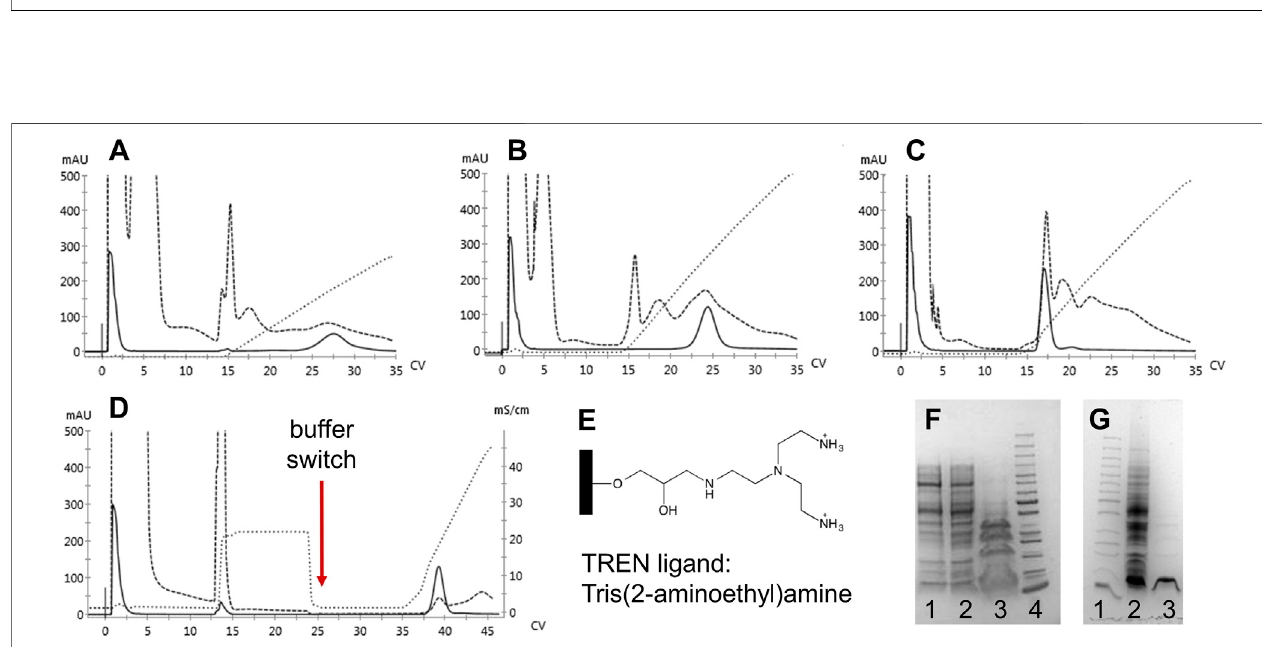
FIGURE 4 | Chromatograms of 1 ml BabyBio TREN chromatographic runs are shown in A-D. Dashed lines indicate the 280 nm UV trace, solid lines indicate 419 nm,anddottedlinesshowtheincreaseinconductivityduringelution.rHbF α 4/ γ 2crudeextractswereloadedontotocolumnequilibratedwithA)20 mMTris-HClpH 8.5, B) 20 mM Tris-HCl pH 7.4, and C) 50 mM MES pH 5.6, and eluted with NaCl gradients. In D) the combined method is shown, where binding of rHbF α 4/ γ 2 is done with 20 mM Tris-HCl pH 8.5, followed by a NaCl wash before the buffer switch to 50 mM MES pH 5.6 and the subsequent elution with NaCl gradient. Panel E) shows the chemical structure ofthe TREN ligand attached to the agarose beads of the resin. SDS-PAGE gels are shown in F and G. F)1: TREN pH 8.5 elution, 2:TREN pH 7.4 elution, 3: TREN pH 5.6 elution, and 4: PageRuler ™ Unstained Protein Ladder (ThermoFisher). G) 1: PageRuler ™ Unstained Protein Ladder (ThermoFisher), 2: rHbF α 4/ γ 2 crude extract, and 3: combined TREN method elution (chromatogram D elution).